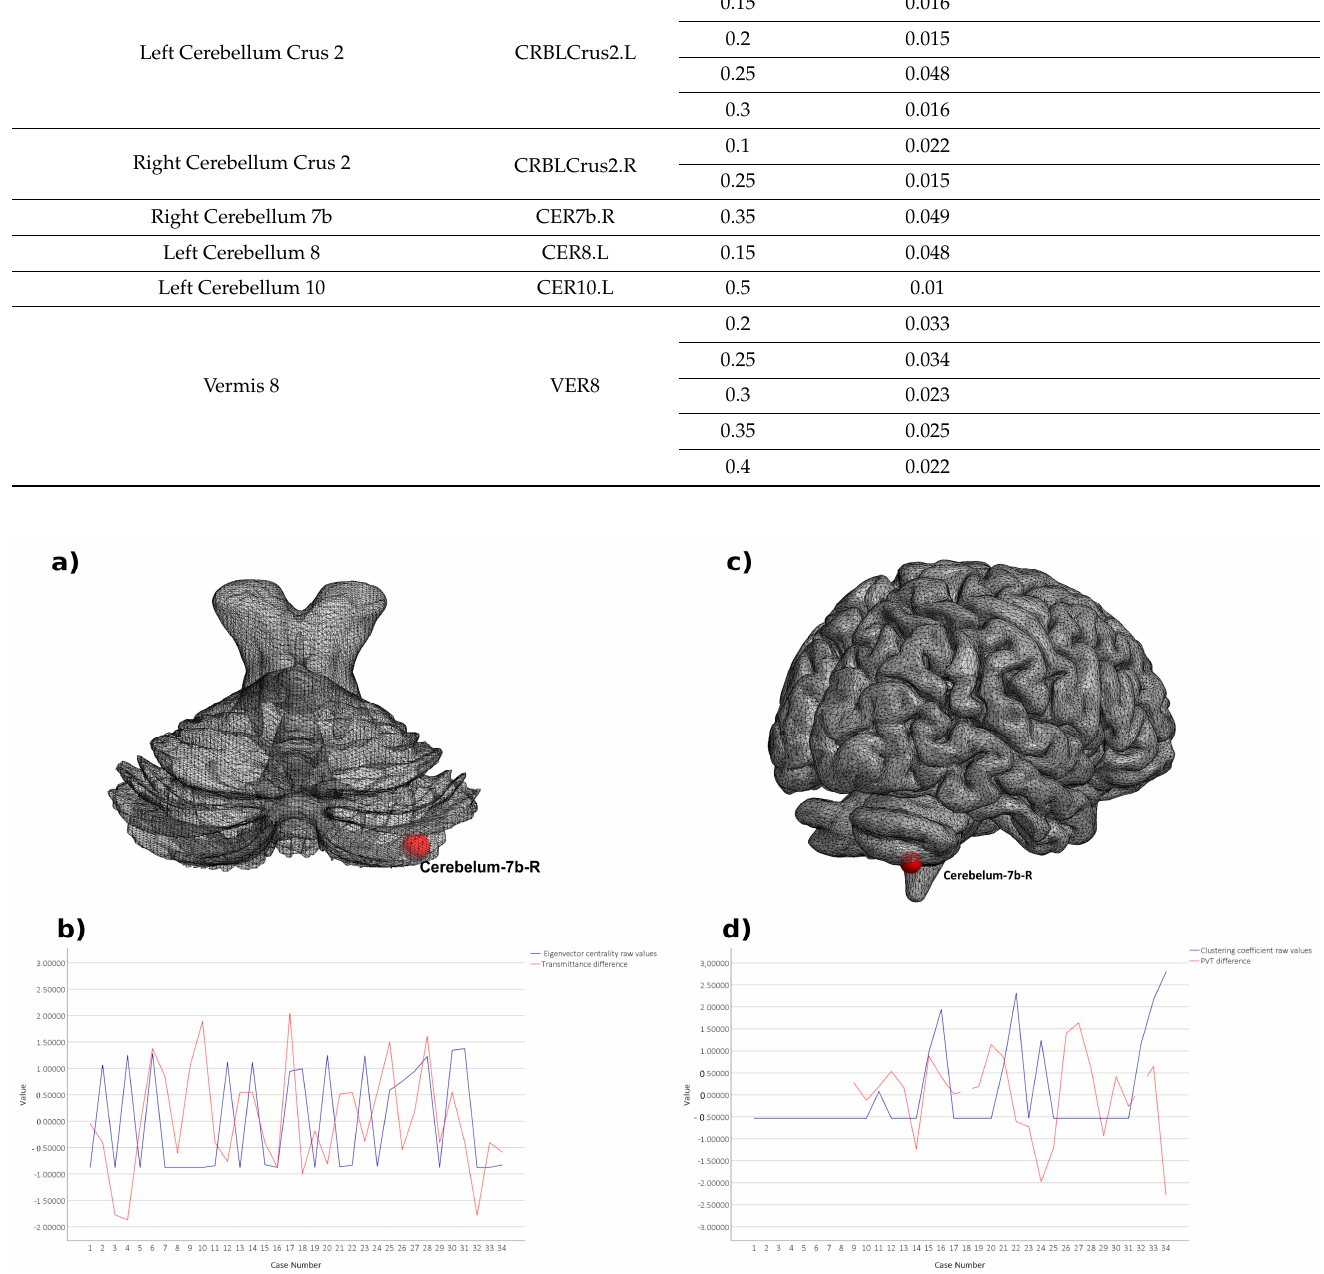
Figure 2. ( a ) Right Cerebelum_7b (aal) ROI rendered on cerebellum surface; ( b ) line plot with Eigenvector centrality raw values and absolute difference in transmittance of each participant; ( c ) Right Cerebelum_7b (aal) ROI rendered on the cortical surface; ( d ) line plot with Clustering coefficient raw values and the difference in PVT of each participant; values for each index were z-score for the purpose of